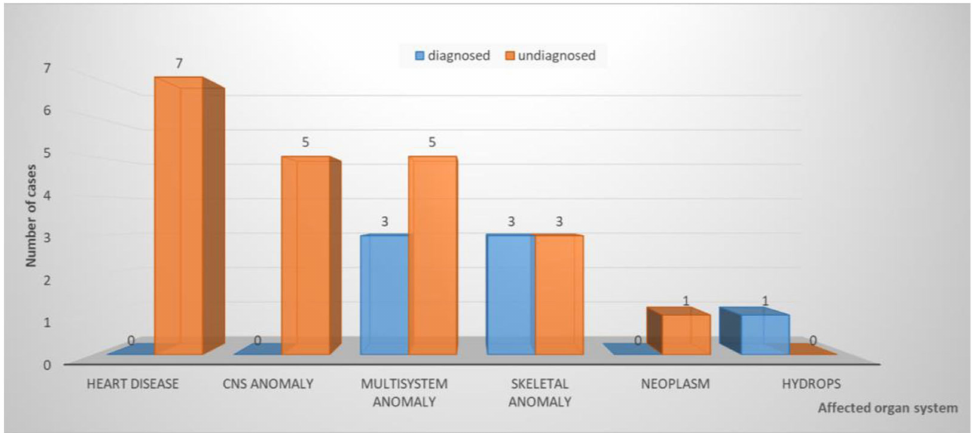
Figure 2. Distribution of fetal WES cases according to organ system. CNS: central nervous system.